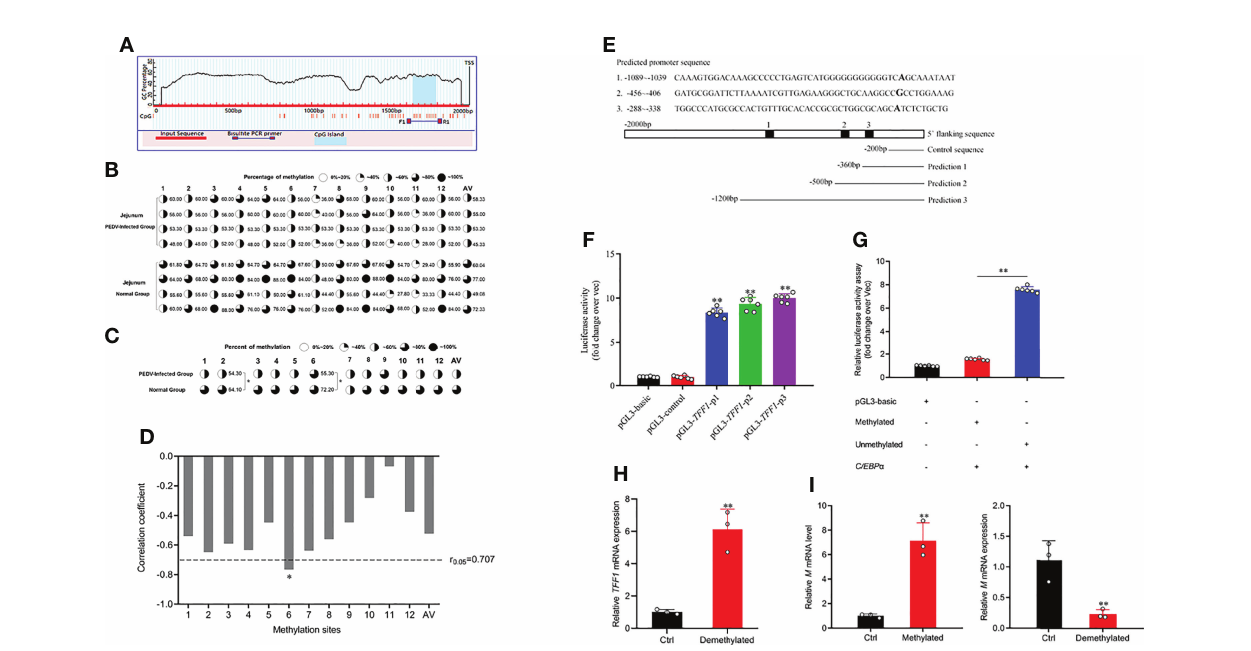
FIGURE 4 | mC-6 methylation is involved in C/EBP a -mediated TFF1 . (A) CpG island prediction of porcine TFF1 upstream 2000 bp promoter region. The long red bar represents the promoter sequence; dark blue line shows designed methylation primer; blue bar indicates the CpG island, TSS means transcriptional start site. (B, C) Bisul fi te genomic sequencing analysis of methylation pro fi le in 12 CpG sites and average methylation status in CpG island of the TFF1 promoter. AV, average methylation status. (D) The correlation analysis between methylation status of each CpG site and mRNA expression of TFF1 in jejunum. (E) Prediction of TFF1 core promoter region and ampli fi cation of truncated fragments. (F) Identi fi cation of core promoter region of TFF1 by four different truncated plasmids. (G) The relative fl uorescence intensity of TFF1 was determined by luciferase reporter assay in vectors treated with or without methyl transferase M.Sss I. IPEC-J2 were co-transfected with C/EBP a -oe and methylated or unmethylated vectors. (H) Relative mRNA expression of TFF1 was determined by RT-qPCR in IPEC-J2 treated with or without 0.1 m M 5 ’ -Aza-2 ’ -dC for 72 hours. (I) Relative mRNA expression of M gene was determined by RT-qPCR in IPEC-J2 treated with or without M.Sss I after PEDV infection at MOI of 0.1. Data are presented as mean values ± SD, using two tailed Student ’ s t-test analysis. * p < 0.05, ** p < 0.01. Each treatment has triplicate biological replicates at